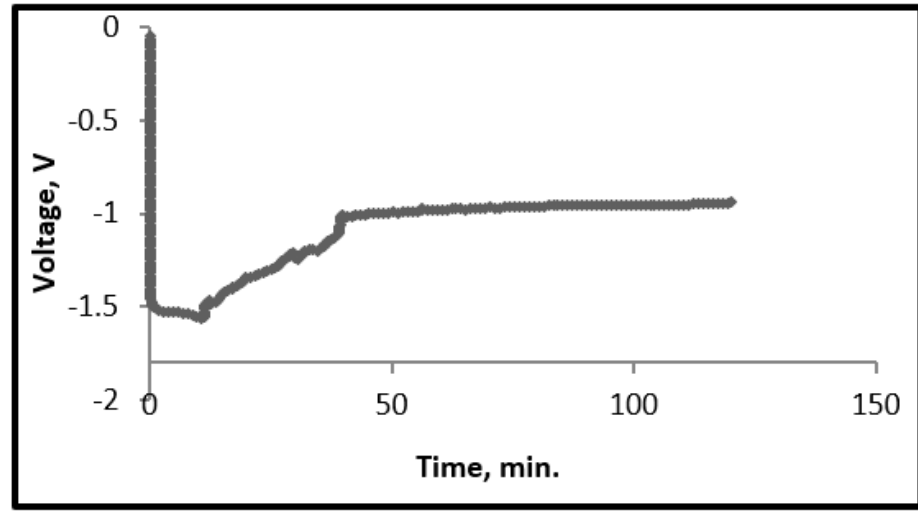
Figure 5. Voltage vs. time profile: current − 0.2 A and duration − 120 min.